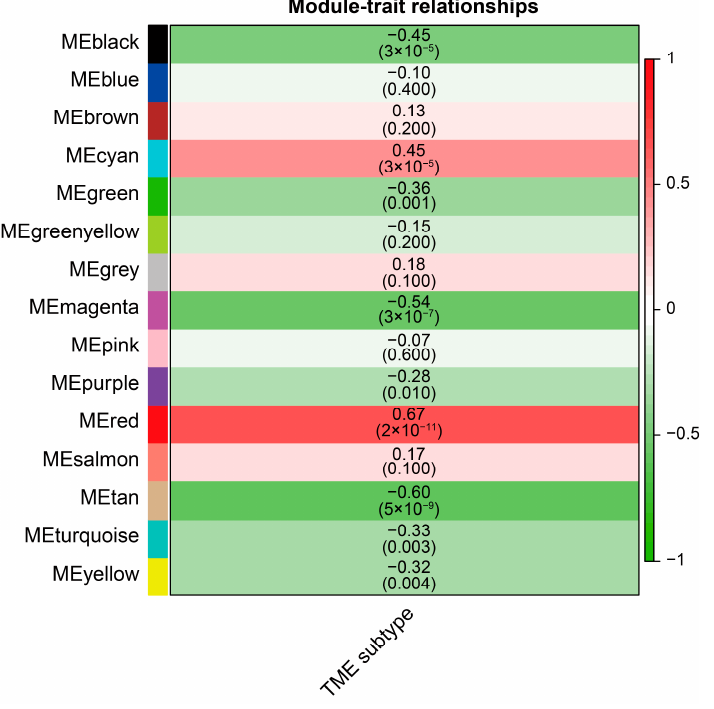
Figure 14. Heatmap showing the correlation between each module eigengenes and TME-related subtypes.